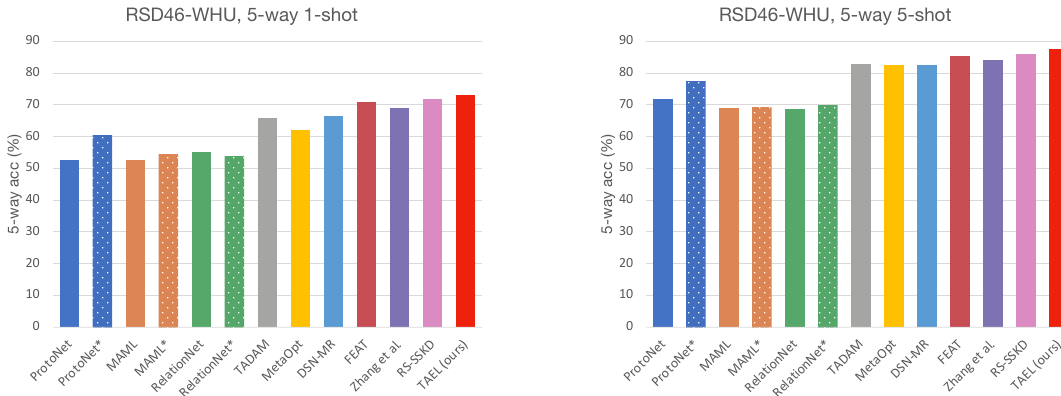
Figure 8. The few-shot classification performance (with 95% confidence intervals) on the RSD46-WHU dataset; the bars with dots indicate the re-implementation of approaches with ResNet-12